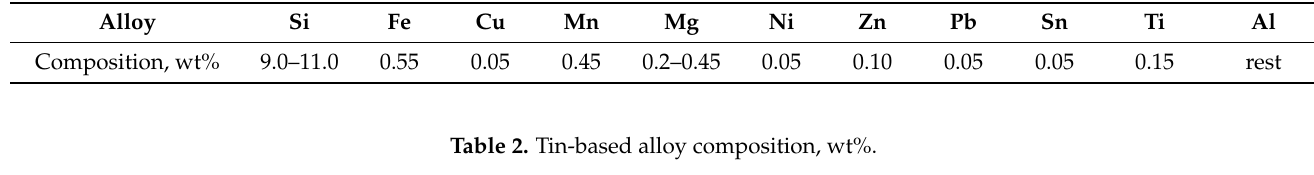
Figure 2. Scanning election microscope images of reinforcement and space holder: ( a ) NaCl parti- cles in the range of 430–50 µm, after ref. [32] (adapted from [32], with permission from Springer Nature 2020); ( b ) alumina particles in the range of 10–30 µm, after ref. [32] (adapted from [32], with permission from Springer Nature 2020); ( c ) optical image of hybrid material test pin. Table 1. AlSi 10 Mg alloy composition, wt%.